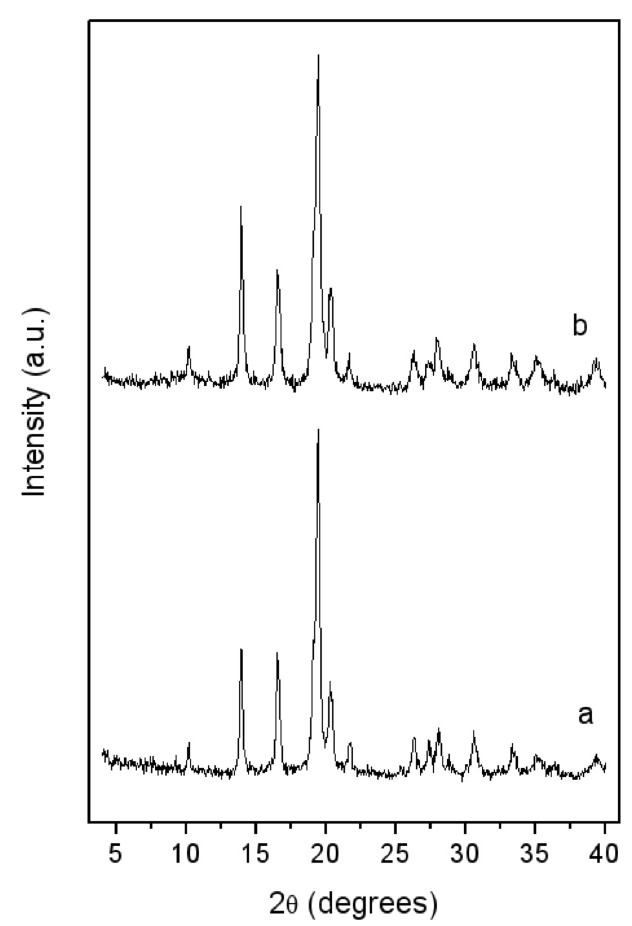
powder after 15 min high energy 5 -SiO blend after 15 min 5 2